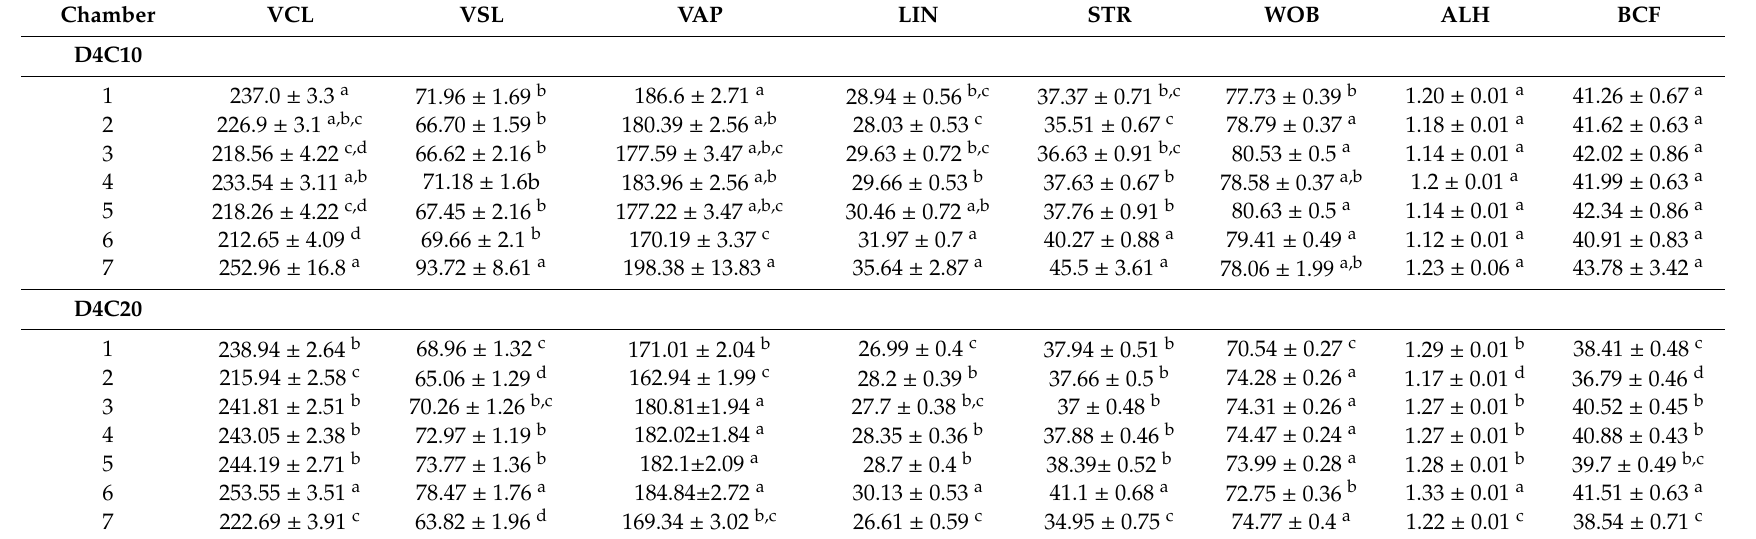
Table 3. CASA motility parameters (mean ± SEM) in di ff erent fields of disposable chamber ISAS ® D4C10 and 20 µ m depth.